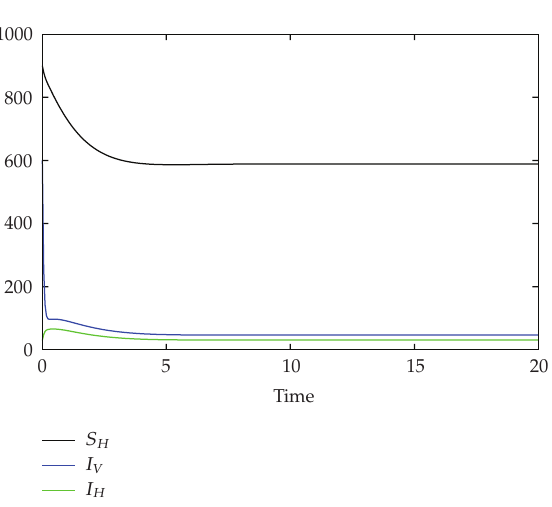
Figure 1: Variation of S H , I H , and I V with time for the parameter values μ (cid:7) 0 . 00042, β 1 (cid:7) 0 . 00004 ,β 2 (cid:7) 0 . 00002, β (cid:7) 0 . 00003, α (cid:7) 0 . 01, m (cid:7) 0 . 005, γ (cid:7) 0 . 0012, and δ (cid:7) 0 . 00002 when R 0 (cid:7) 17 .